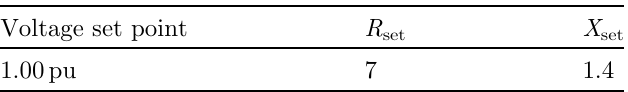
Fig. 3. Q ( V ) control curve where ± Q rated is limited to a power factor range of ±0.90 PF. Table 1. Q ( V ) characteristics data (with a deadband). Table 2. 132/22 kV Transformers ’ LDC settings in